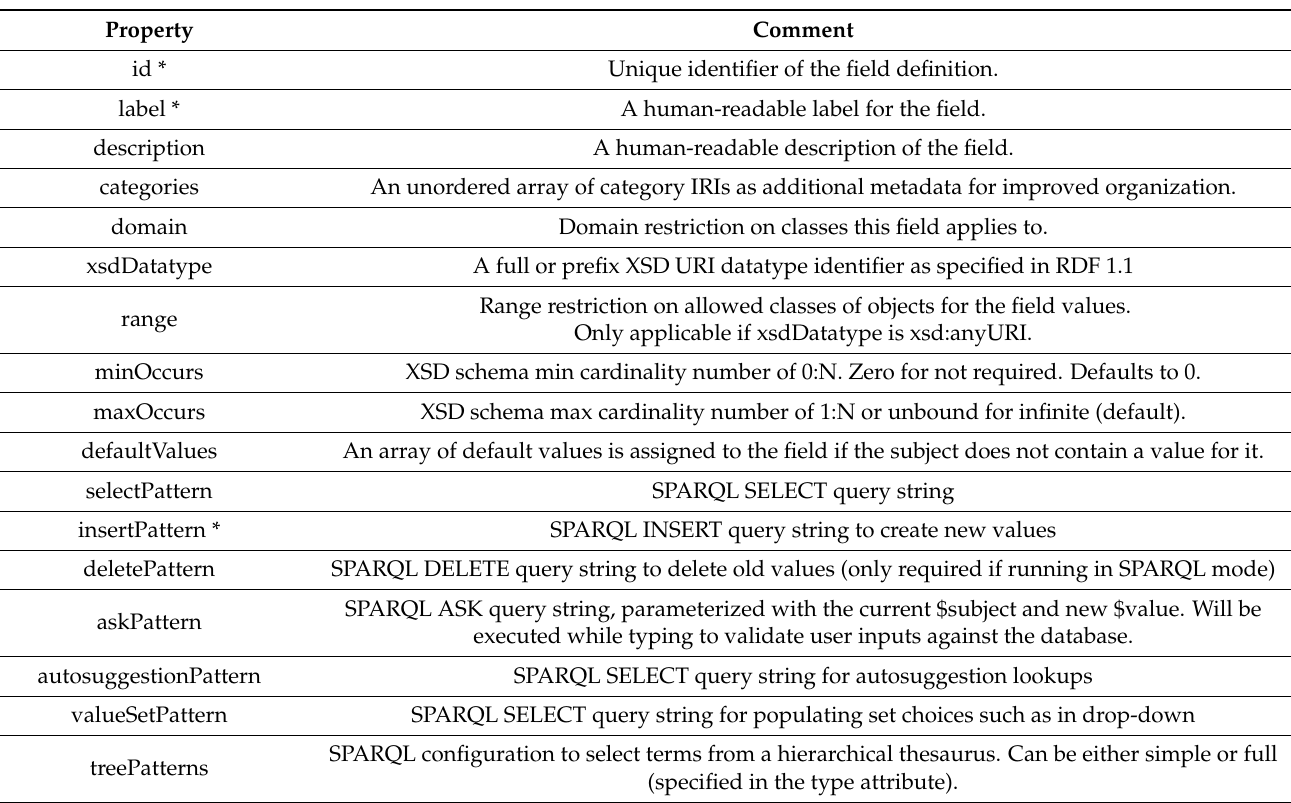
Table 5. Field definitions (* required